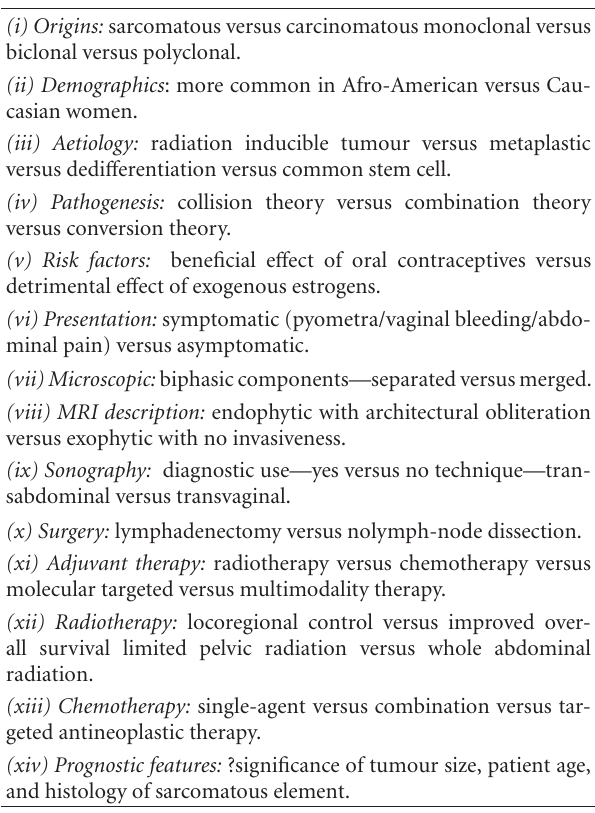
Table 2: Controversies in uterine